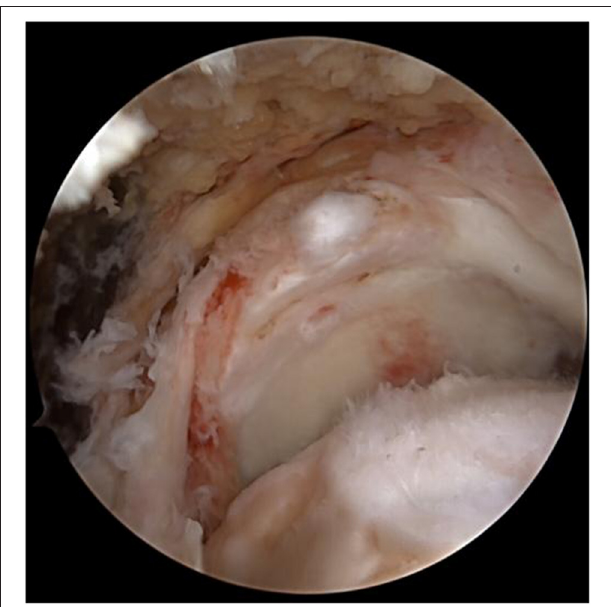
FIGURE 4 | The tendon autograft was thereby introduced into the shoulder joint from the posterior side.